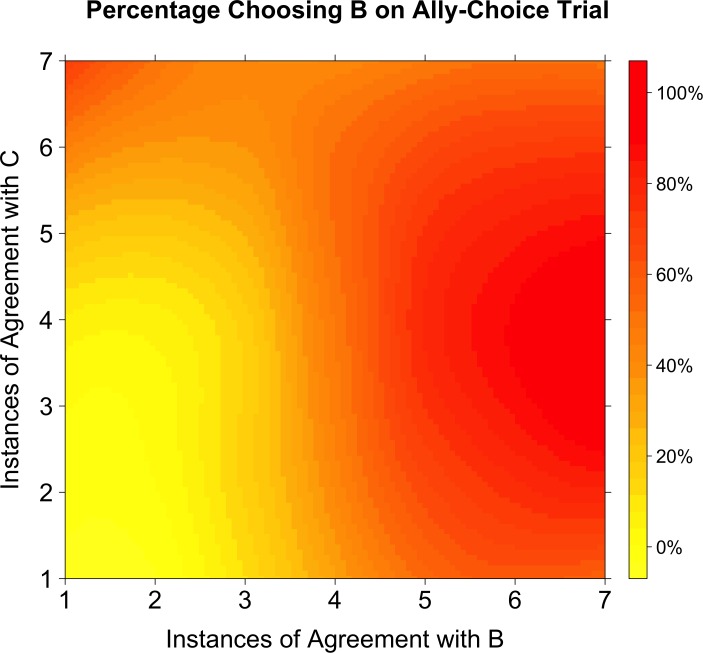
Percentage choosing Agent B as a function of agreement with Agents B and C.A smoothed level plot illustrates that as agreement with both Agents B and C increases (towards the top-right corner), so does the probability of choosing Agent B on the ally-choice trial. If Agent B had been the only influence on whether or not participants chose Agent B on the ally-choice trial, then the transition from yellow to red should only occur in the horizontal direction (as agreement with Agent B increases). Instead, there is a radial transition from the bottom-left corner.